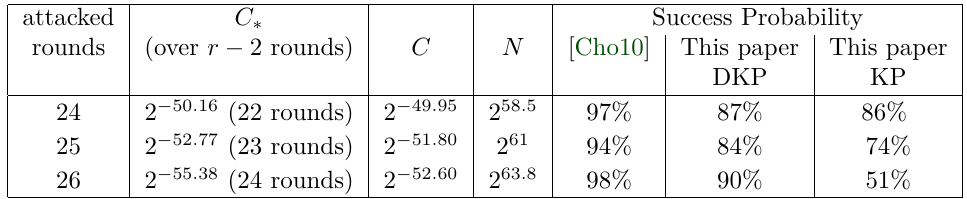
Table 4: Multidimensional linear attacks on PRESENT. Computation of the success probability for an advantage a of 8